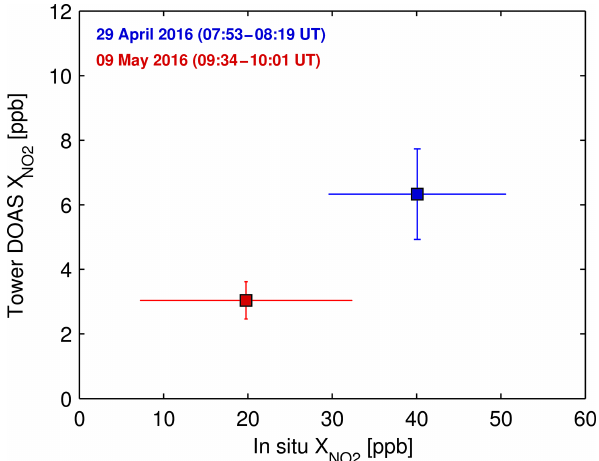
Figure 21. Averaged X NO from tower DOAS off-axis measure- 2 ments as a function of averaged in situ surface X NO on 29 April 2 (blue) and 9 May (red) 2016. The mean and standard deviation of the former are calculated for round 4 (29 April) and round 6 (9 May), whereas mean and standard deviation of the latter are calculated from measurements of in situ stations falling within the circle determined by hOPL of the individual tower DOAS off-axis measurements (see Fig.